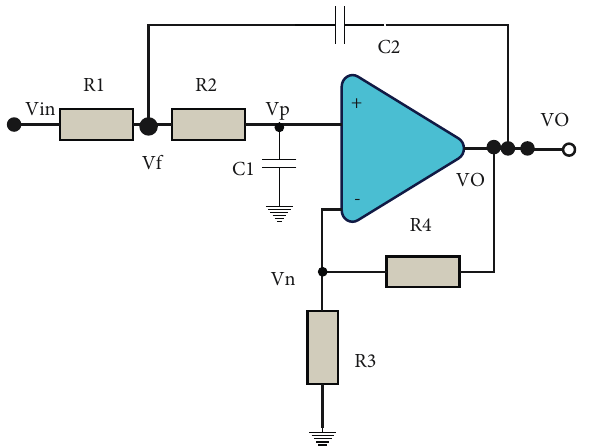
Figure 5: Circuit model diagram of digital S – K forming.